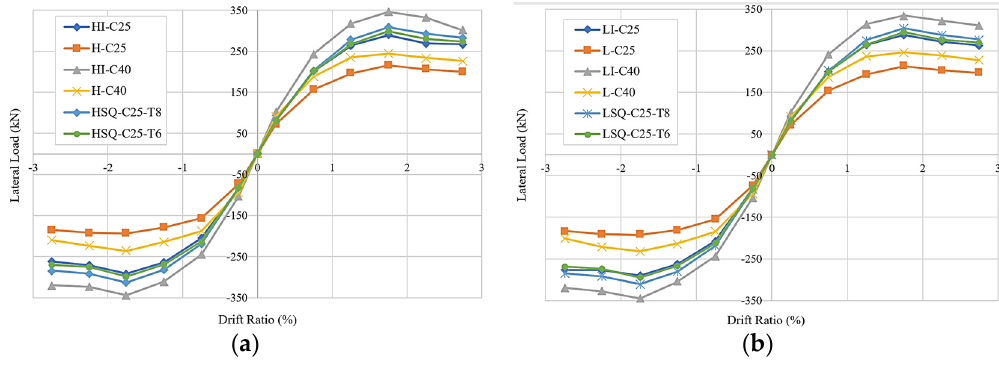
Figure 19. Envelope curves of frame models: ( a ) HD; ( b ) LD. Table 7. Lateral load capacities of 12 frame models.